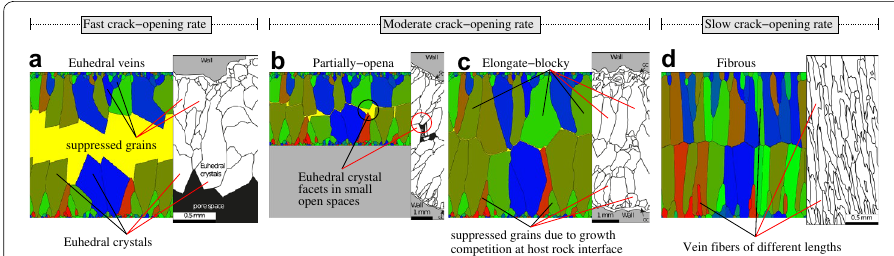
Fig. 8 Comparison of simulated vein morphologies with natural samples. The sketches of natural samples (in gray scale) are drawn from the natural samples of calcite veins in Jurassic limestones from southern England, shown in Fig. 1. a Euhedral, b partially open, c elongate-blocky and d fibrous veins. The wall rock (gray) in the sketch of fibrous vein is not contained in the sample, but it is towards the base of the image. The simulated veins exhibit strong resemblance with the natural samples suggesting a pronounced role of crack opening rates and initial crack width in the formation of different vein